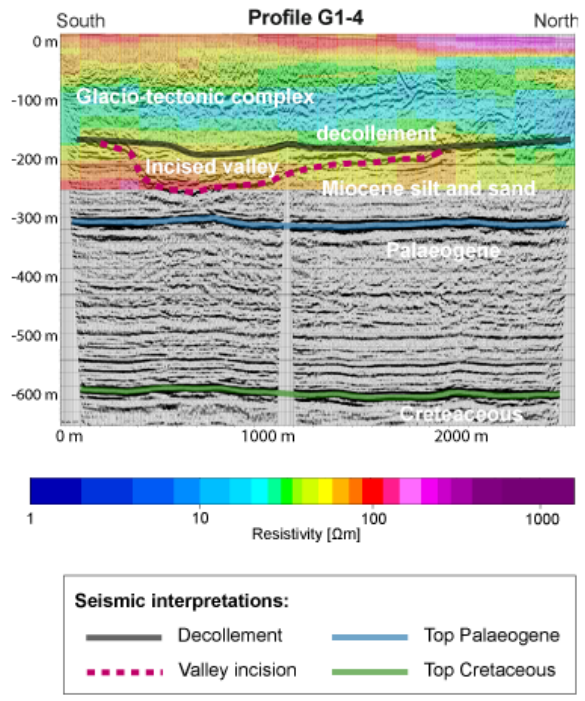
Fig. 8. Interpreted seismic section (profile G1–4) with SkyTEM resistivity data showing glaciotectonised Miocene and Pleistocene layers over an incised valley structure. For location of the sections, see Figs. 5 and 9. Vertical exaggeration 3 × .